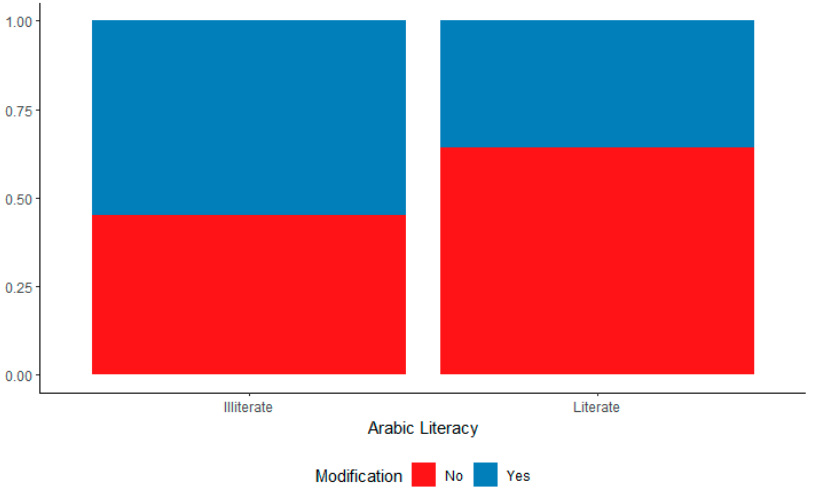
Figure 10. Production accuracy of Arabic coda consonant clusters by literate and non-literate FDHs.